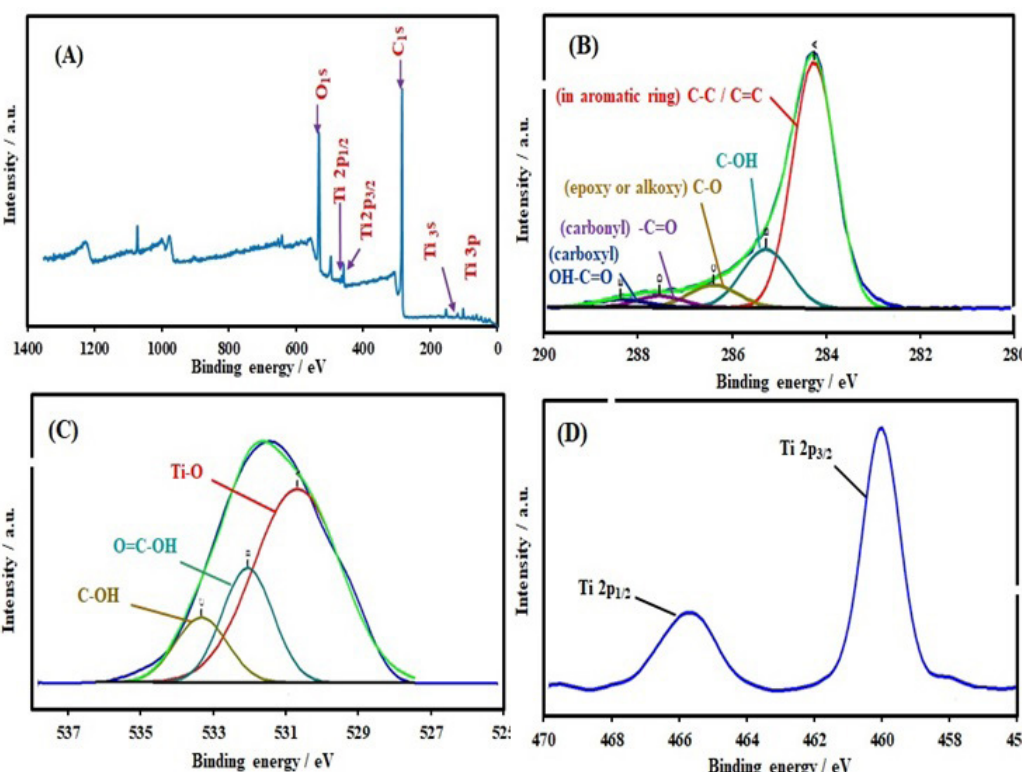
Fig. 6. XPS spectra analysis of RGO/TiO